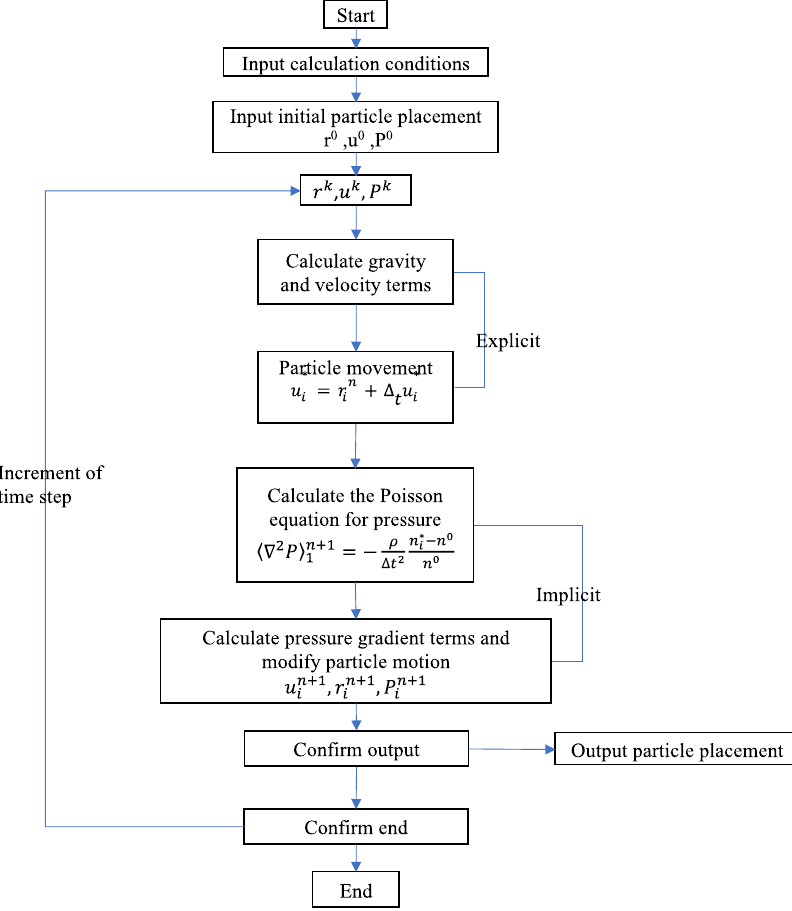
Figure 2. Calculation algorithm flowchart for MPS.